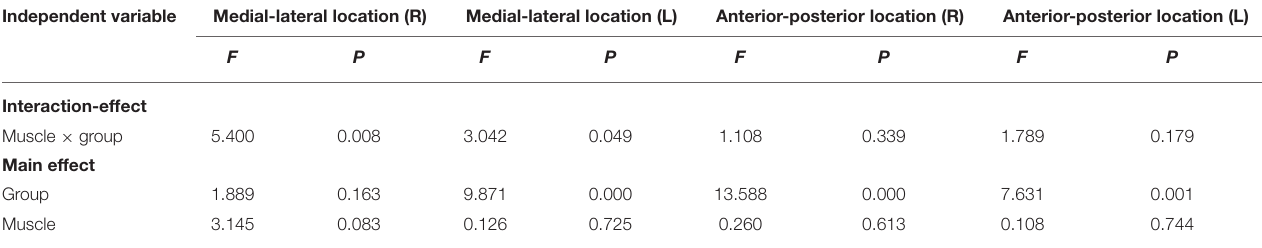
TABLE 4 | Summary of F- and P -values for medial-lateral and anterior-posterior coordinates in the left and right hemispheres of the healthy and CLBP groups. Independent